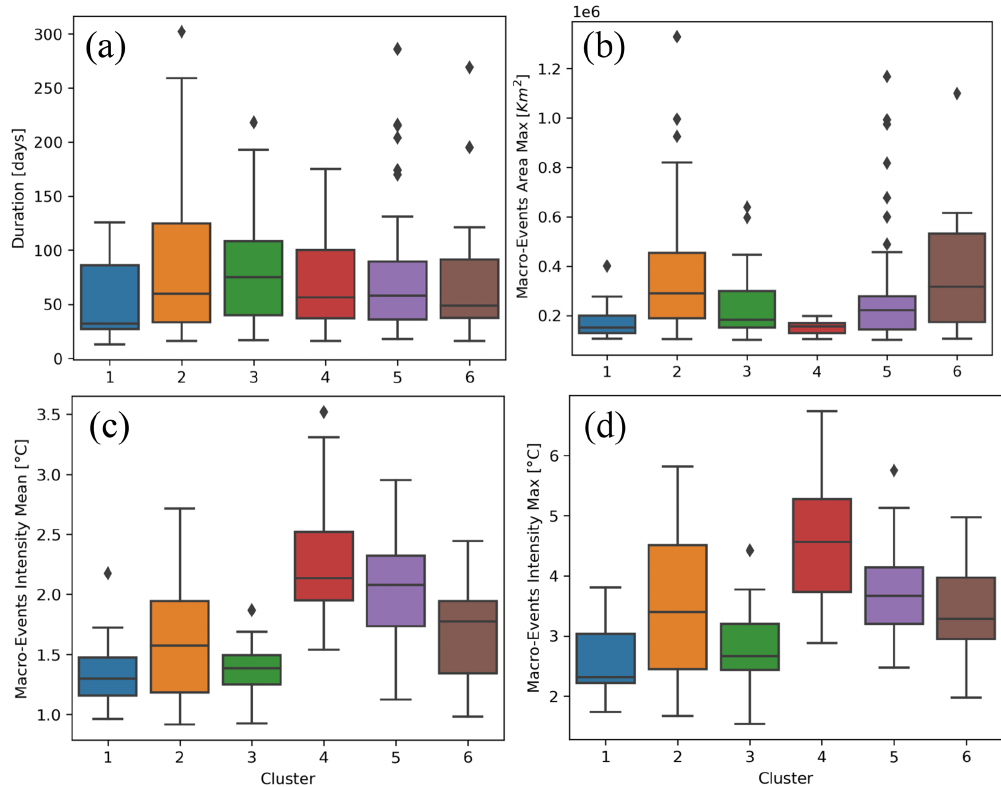
Figure 11. Box plots for (a) duration, (b) area, (c) intensity mean, and (d) intensity maxima for each cluster.